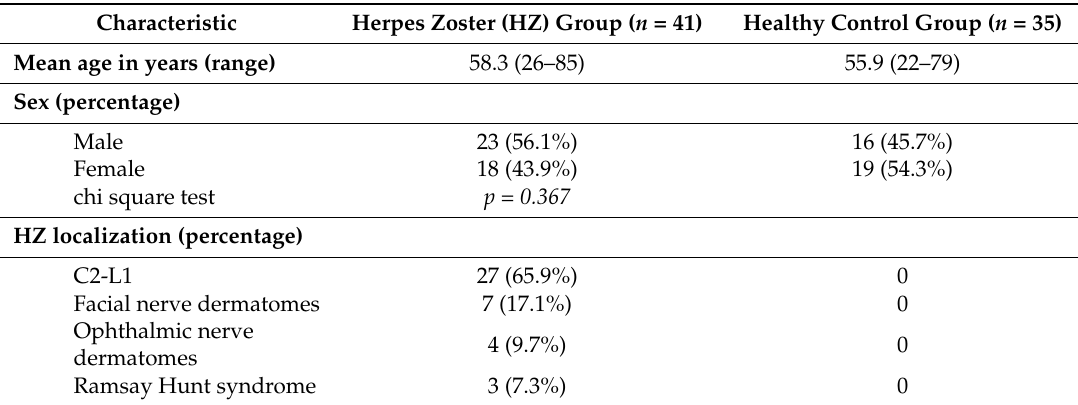
Table 1. Patient